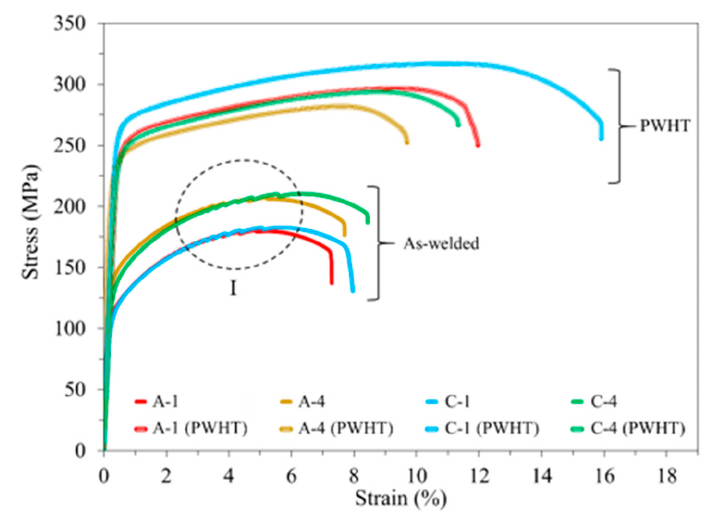
Figure 9. Stress–strain curves of FSW and PWHT samples.